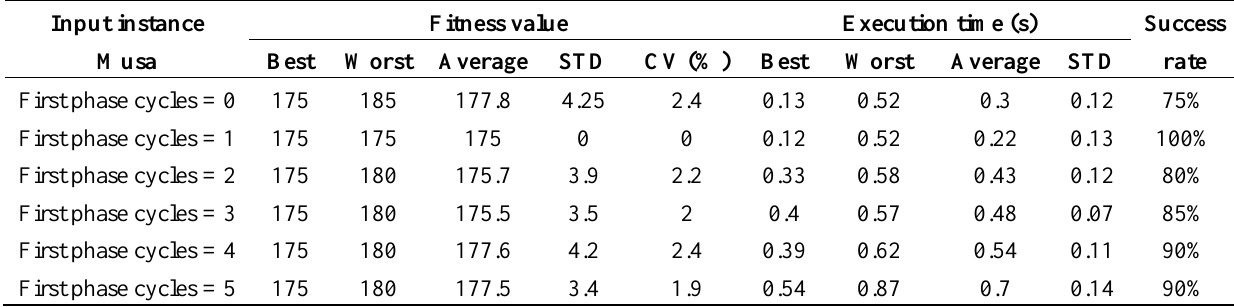
Table 11. Investigating the effect of first phase’s number of cycles for input instance,